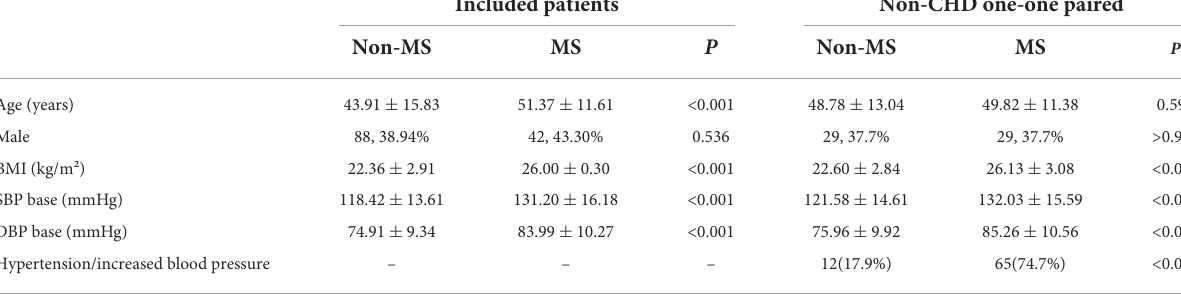
TABLE 1 The baseline characteristics of included patients and non-CHD one-one paired. Included patients Non-CHD one-one paired Non-MS